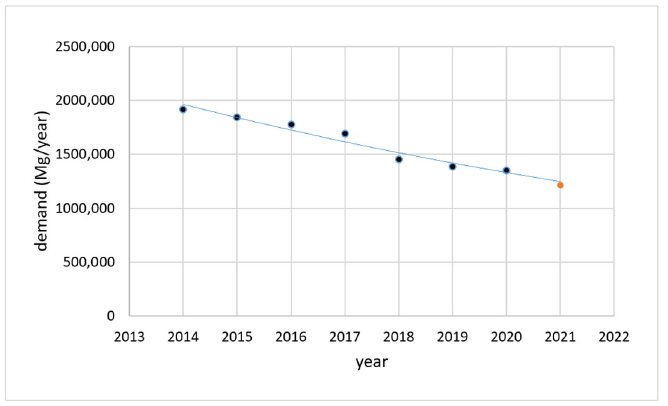
Figure 5. Demand of the “Export 7” group in the years 2014–2020 with the forecast for 2021.